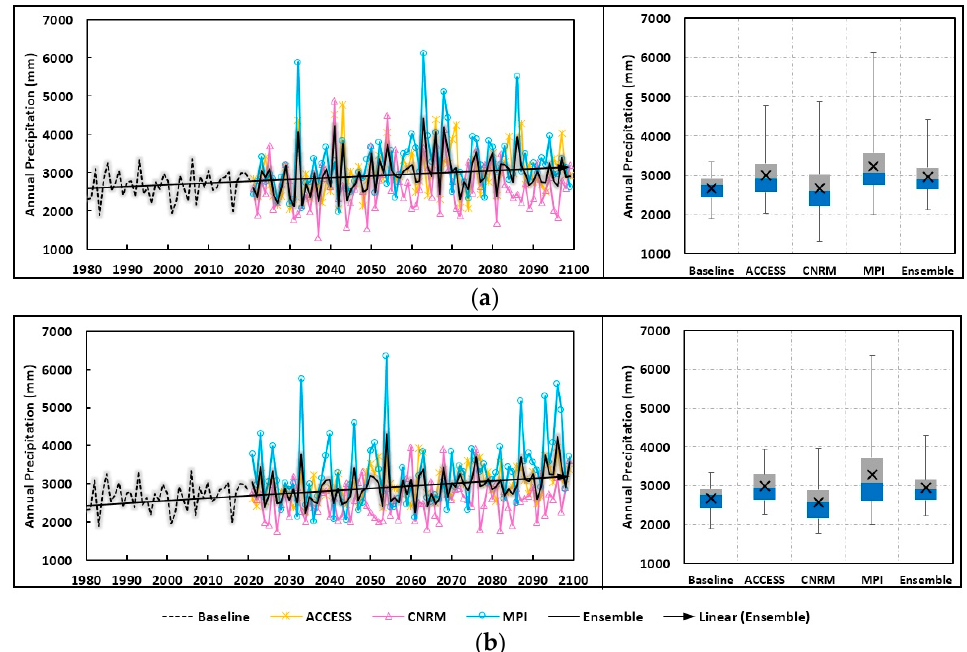
Figure 3. Projected precipitation under ( a ) RCP4.5 and ( b ) RCP8.5 climatic scenarios.